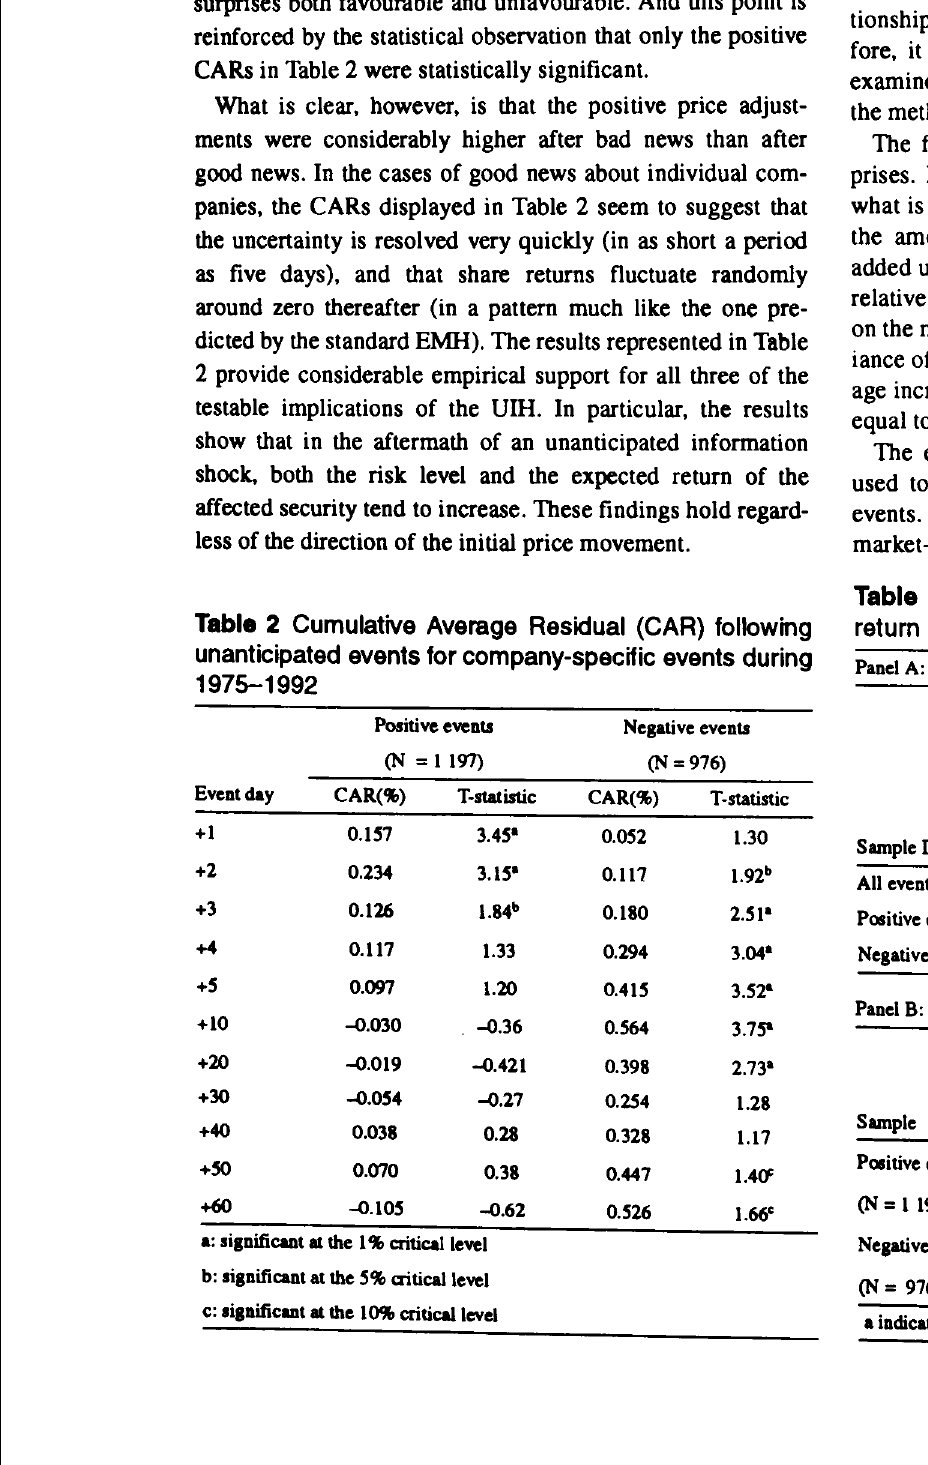
Panel B: Event magnitudes and risk changes for individual company